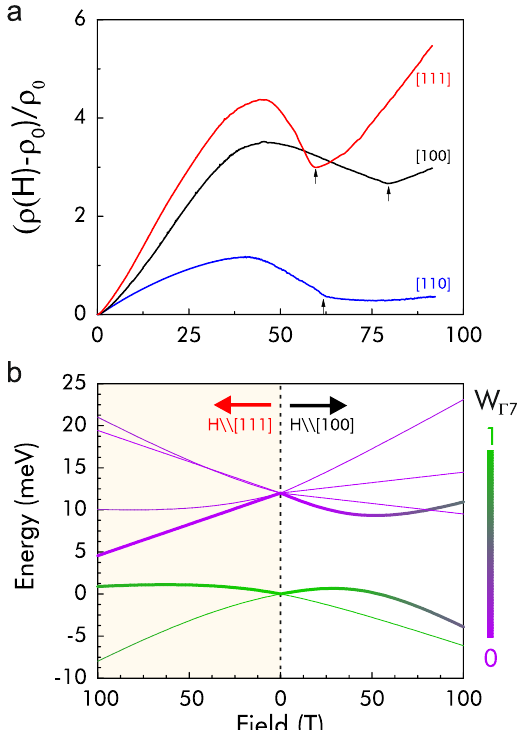
Fig. 2 a Magnetoresistance of CeIn 3 at 600 mK for fi elds up to 92 T along the directions [100], [110], and [111]. While for both the [110] ( blue ) and [111] ( red ) directions a break in slope (marked by arrows ) indicates the destruction of the AFM order at a critical fi eld H c ≈ 60 T, the AFM phase exists up to substantially larger fi elds H c ≈ 80 T along the [100] direction ( black ). b Calculated crystal fi eld-level spectrum of CeIn 3 for fi elds along [100] and [111]. For H //[100] the upper energy level of the fi eld-split ground-state doublet and the lowest- energy state of the upper quartet ( bold lines ) anticross in the fi eld range where the critical fi eld anisotropy appears. The overlap of each wavefunction with the ground-state doublet in zero fi